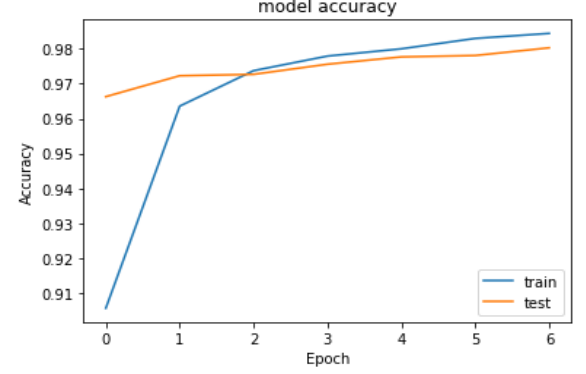
Figure 8. The performance of the proposed model.